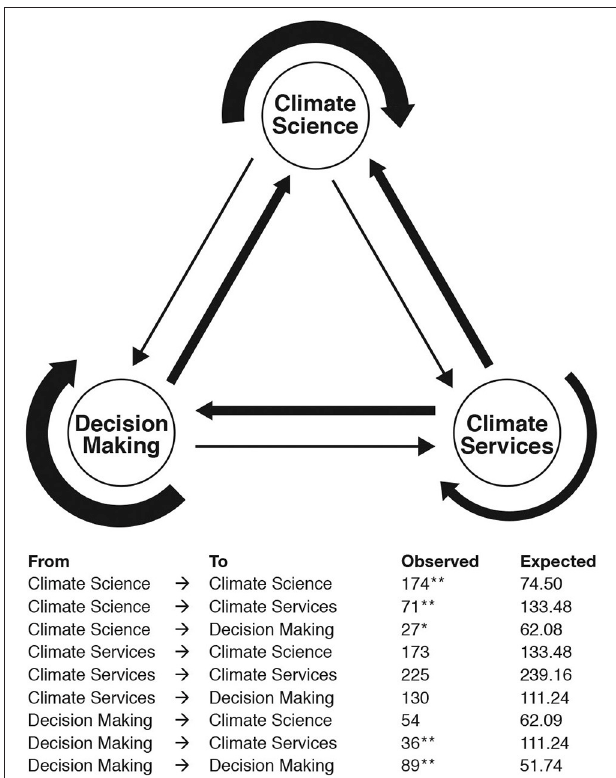
FIGURE 2 | Interactions among those involved in climate science, climate services, and decision making. Significant differences were detected through interpretation of a chi-square statistical test (df = 8; * p ≤ 0.05; ** p ≤ 0.01). The thinnest and thickest lines represent significantly under- and over-predicted, respectively. Regular lines represent no significant difference between observed and expected. Individuals with multiple roles were not included in the figure as interviewees could only specify alters as having mutually exclusive roles.